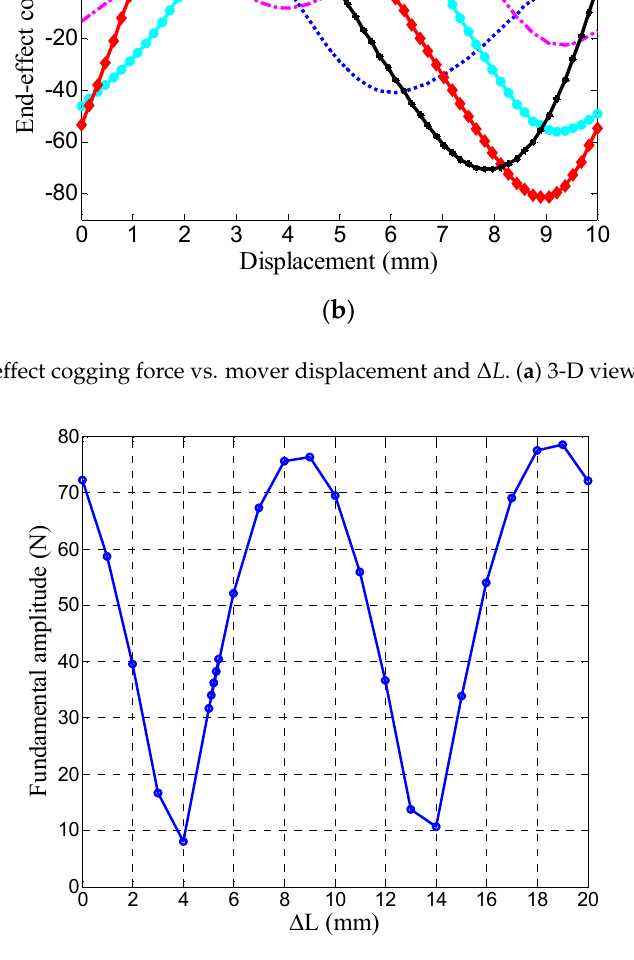
Figure 6. First-order end-effect cogging amplitude as a function of Δ L .